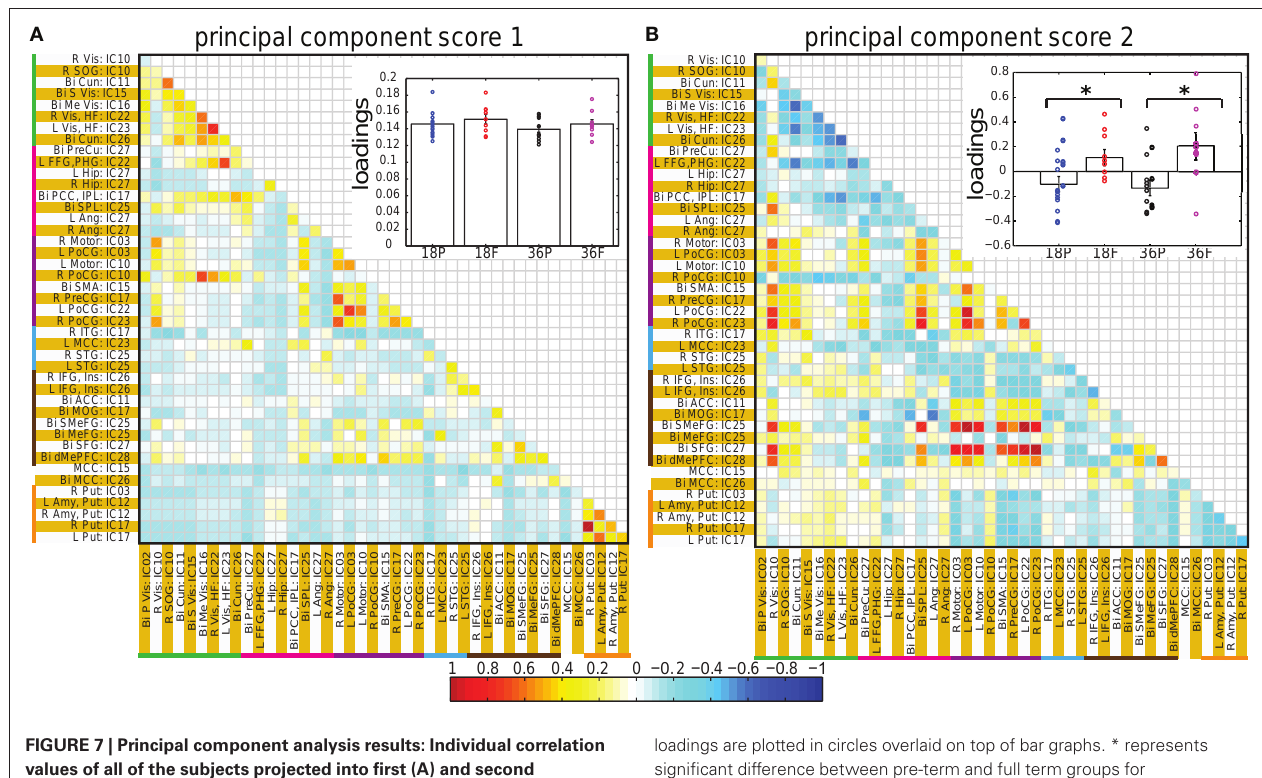
Figure 7 | Principal component analysis results: individual correlation values of all of the subjects projected into first (A) and second (B) principal component space. The insets in each panel show bar graphs of group mean loadings with standard errors for each of the four groups for the corresponding component score. Subject specific